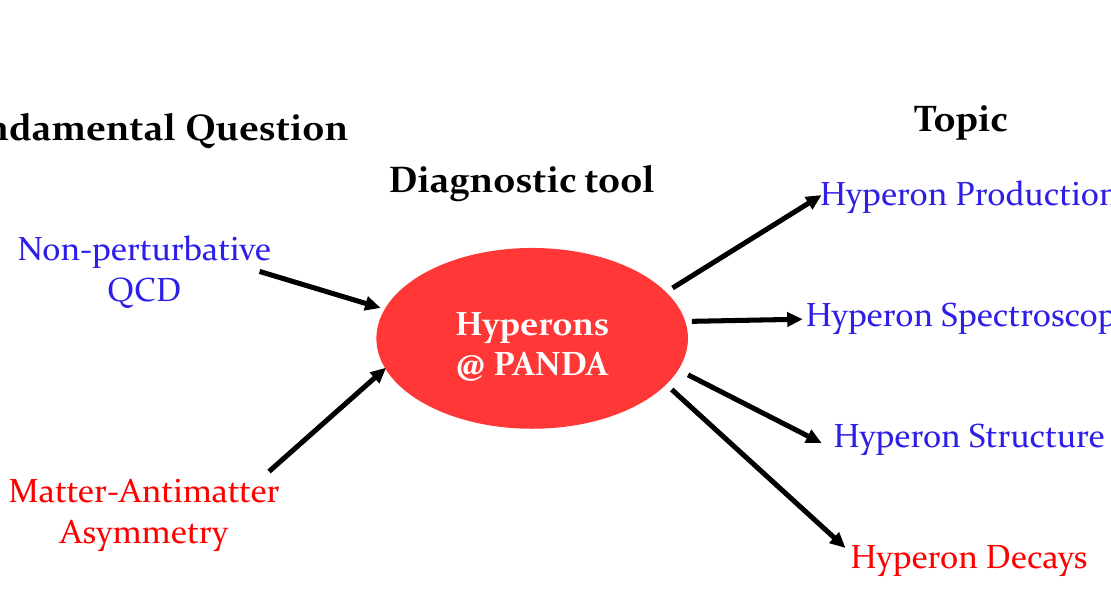
Figure 3. Conceptual map of hyperon physics in PANDA. It shows how the two over-arching fundamental questions (left) can be approached by a common diagnostic tool, i.e. hyperons (middle), from which the di ff erent subtopics emerge